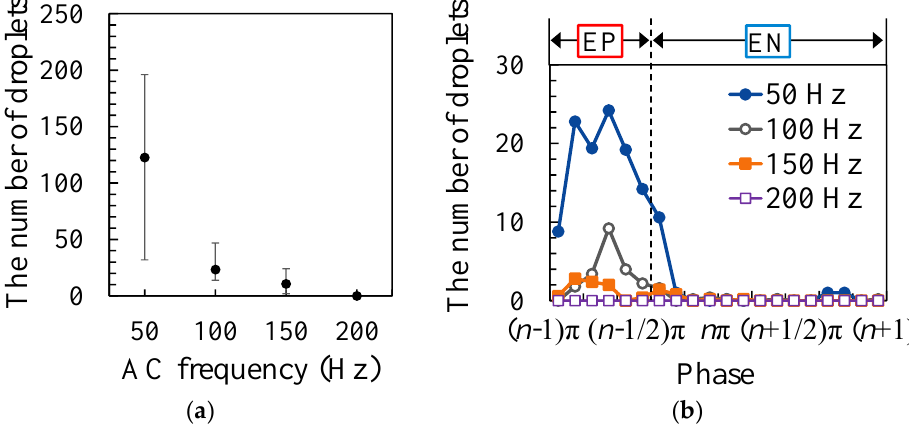
Figure 10. The number and timing of droplet ejection for different AC frequencies: ( a ) number of droplets; ( b ) timing of droplet ejections.